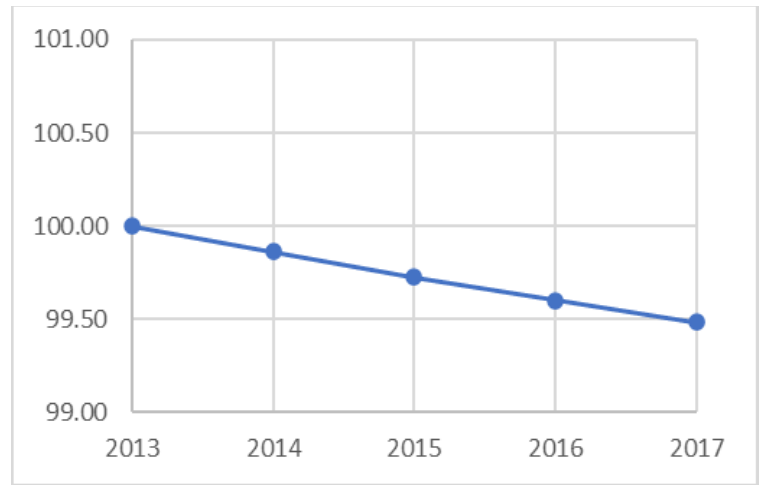
Figure 15. HDI trend as a percentage of its 2013 value.